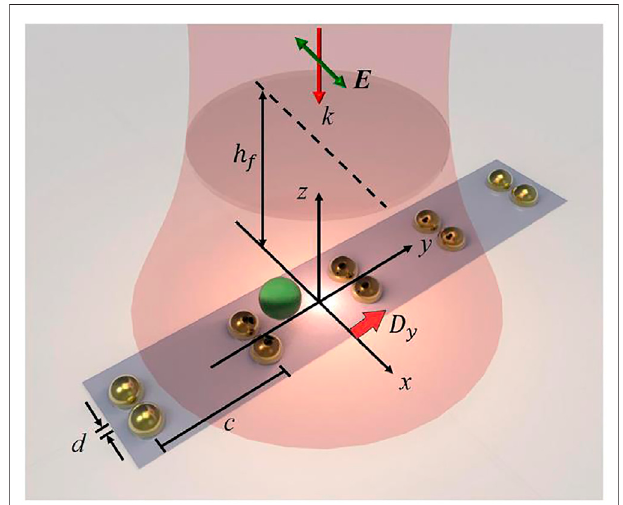
FIGURE 4 | Con fi guration of a 1D gold dimer array trapping a nanoparticle using a normally incident Gaussian beam. The dimer gap, lattice constant and displacement along y are denoted respectively by d , c , D y . The Gaussian beam is polarised along x and has parameters h f ew 0 . [Reproduced from Liaw et al.